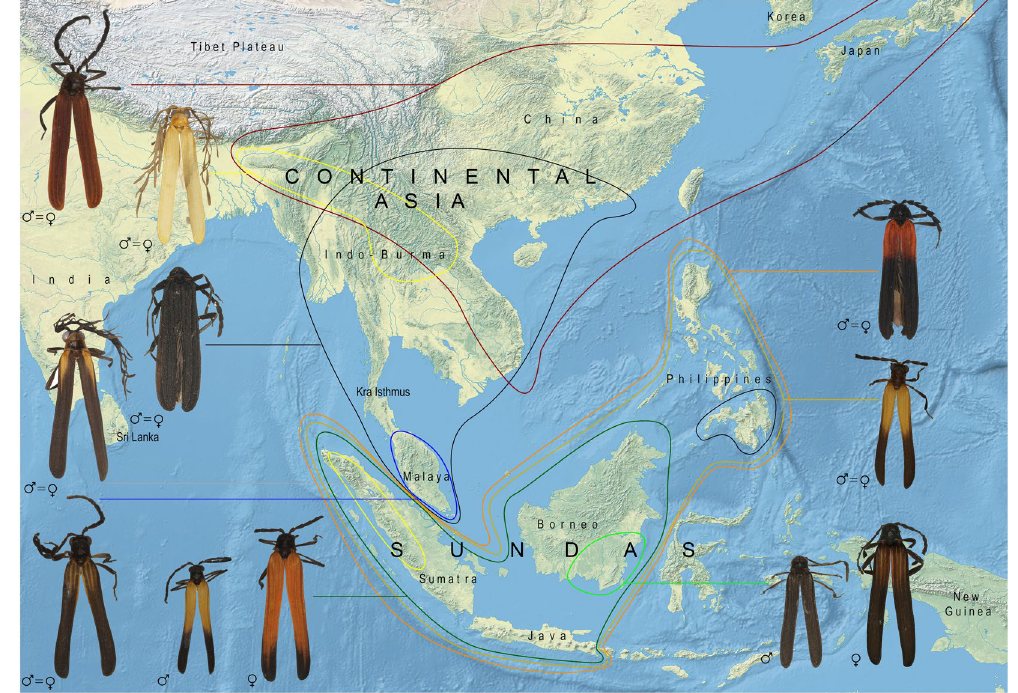
Figure 2. Distribution of mimetic patterns of Dilophotes . The map was downloaded from Natural Earth server (http://www.naturalearthdata.com) and edited using Adobe Photoshop CS6 (http://www.adobe.com/products/ photoshop.html).